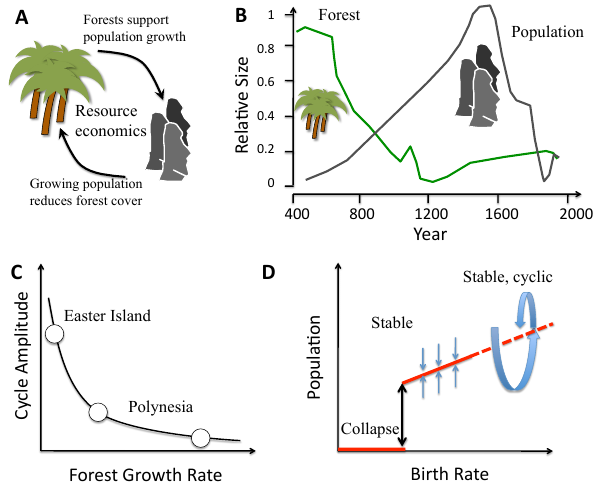
Fig. 3. Illustration of the potential value of minimal non-linear mod- els to interpret interactions between nature and society. This illustra- tion follows the analysis of Taylor and Brander (1998), who consid- ered a resource-economics model of the society on Easter Island, which was dependent on a palm forest resource (A) . Archaeolog- ical evidence illustrates the interaction of this forest resource with the human population, which follows a cyclical pattern with varying amplitude, including a large “crash” in human population (B) . Simi- lar dynamics are not seen on other Islands in Polynesia, and arose in Easter Island (according to the modeling and biological evidence) because of the unusually slow growth rates of the palm trees (C) . Simple models can make predictions about complex system behav- ior – for instance as a function of the birth rate (and other control parameters), the long-term dynamics of this system tend to either complete collapse (explaining, perhaps the 12 “mystery” islands of Polynesia which were once colonized but ultimately abandoned), a simple approach to a stable population through time or a com- plex approach to a stable population via limit cycles with variable